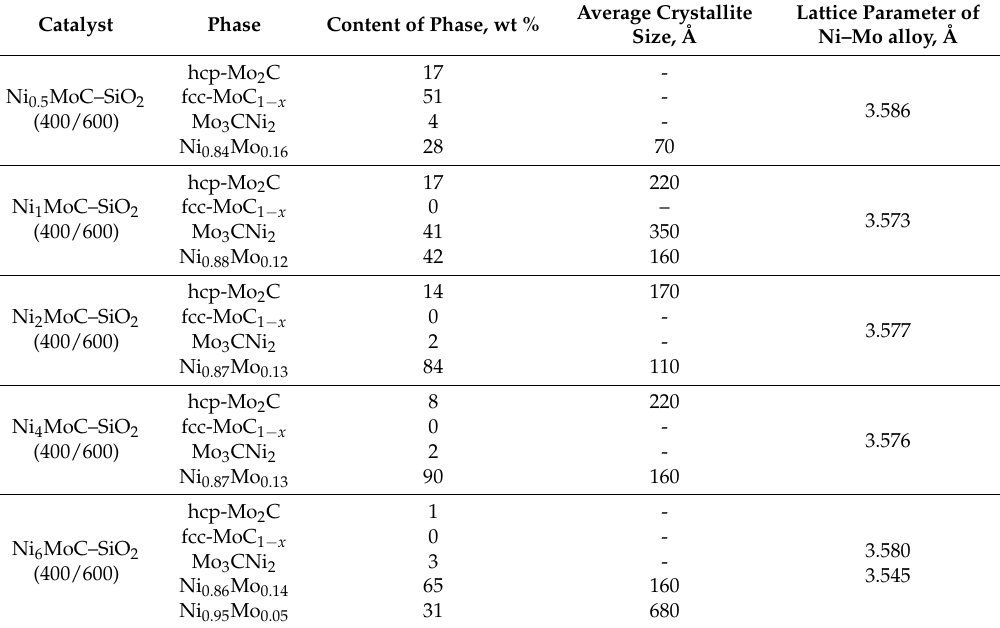
Table 4. Phase composition of the calcined and reduced Ni x MoC–SiO 2 (400/600) catalysts.